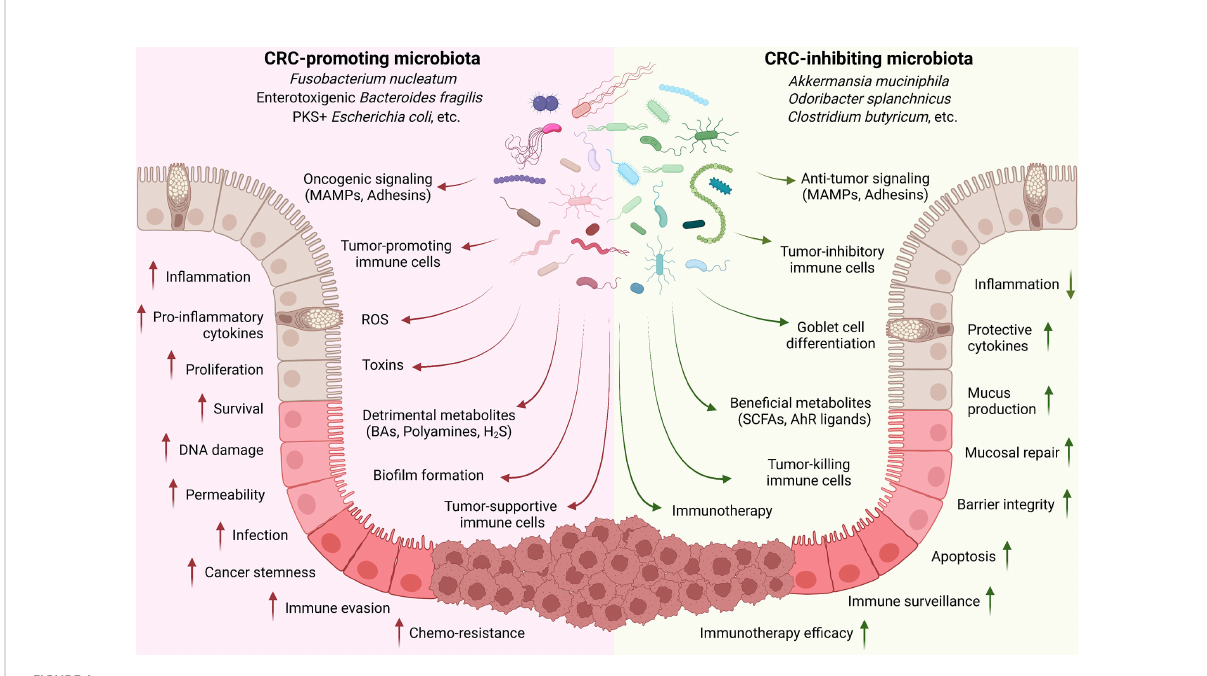
FIGURE 1 Implication of gut microbiota in CRC development. Commensal microbiota plays critical roles in controlling CRC development. Cancer- promoting microbiota directly adheres to the epithelial cells through MAMPs and adhesins for oncogenic signaling activation (such as Wnt/ b - catenin); produce toxins and detrimental metabolites (such as secondary BAs, polyamines, and H 2 S); and induce tumor-associated immune cell populations (such as TAM, TAN, MDSC, and Treg) to regulate the in fl ammation, tissue damage, cell proliferation and survival, immune evasion, and drug resistance. On the contrary, CRC-inhibiting microbiota can directly trigger the anti-tumor signaling activation in epithelial cells; produce bene fi cial metabolites (such as SCFAs and AhR ligands); and stimulate tumor-preventing and -killing immune cells (such as CD8, Th1, Th17, and